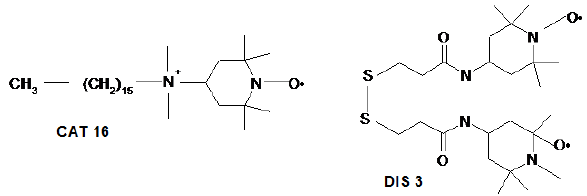
Figure 1. The spin probes used in this study.